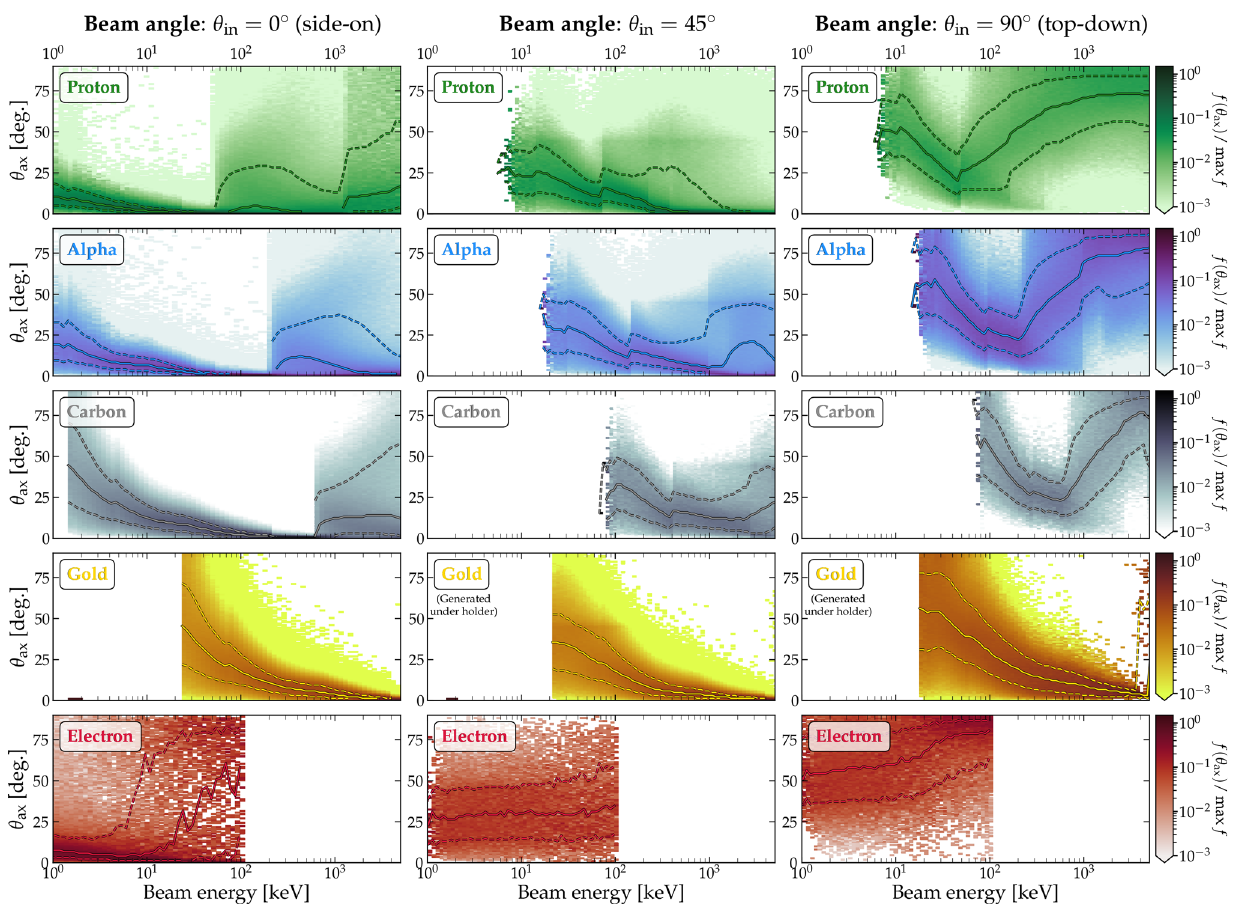
Fig. 9 As in Fig. 8 but now for the probability distributions of the axial scattering angle f (θ ax )